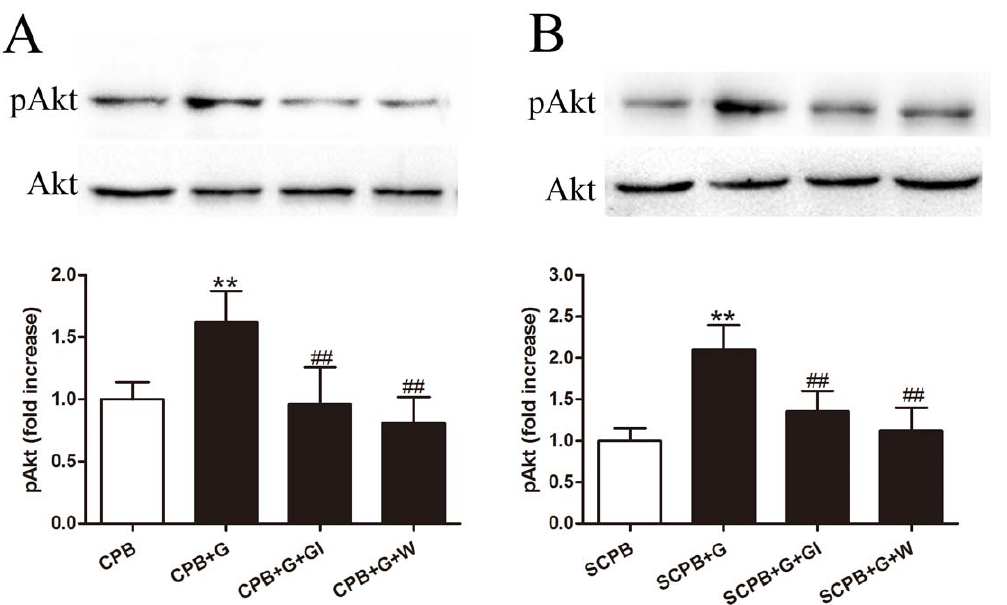
Figure 6. Phosphorylation of Akt invivo (A) and invitro (B) following different treatments. Values presented are mean 6 SEM. N=6; G, ghrelin; GI, [D-Lys3]-GHRP-6, ghrelin inhibitor; W, wortmannin, a PI3K inhibitor. ** P , 0.01 vs. Sham, ## P , 0.01 vs. CPB or